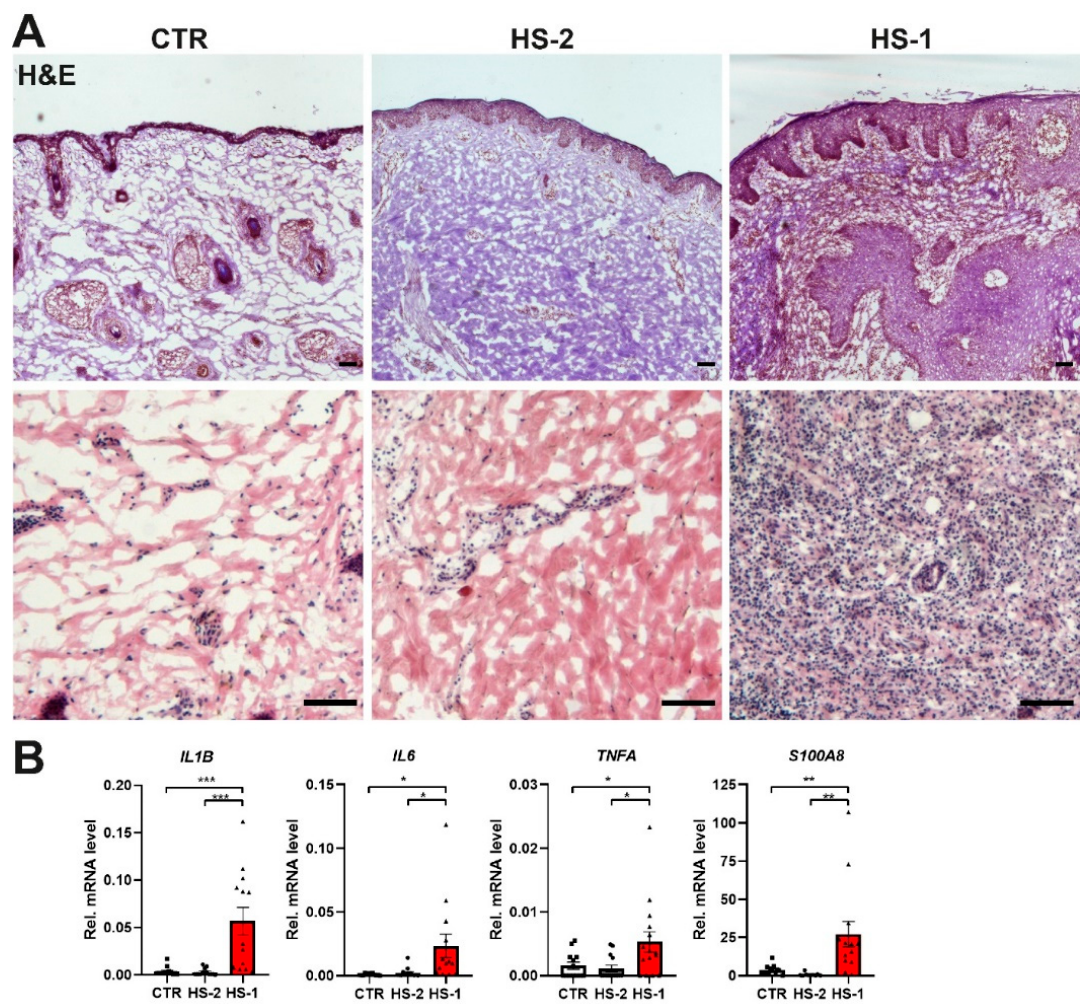
Figure 2. Abundant inflammation in the hidradenitis suppurativa skin. ( A ) H&E staining of the CTR, HS-1, and HS-2 skin sections at different magnification. ( B ) qRT-PCR analysis of IL1B, IL6, TNFA and S100A8 transcript level. Scale bar 100 µ m. Data represent the mean ± SEM. * p < 0.05, ** p < 0.01, *** p < 0.001 by one-way